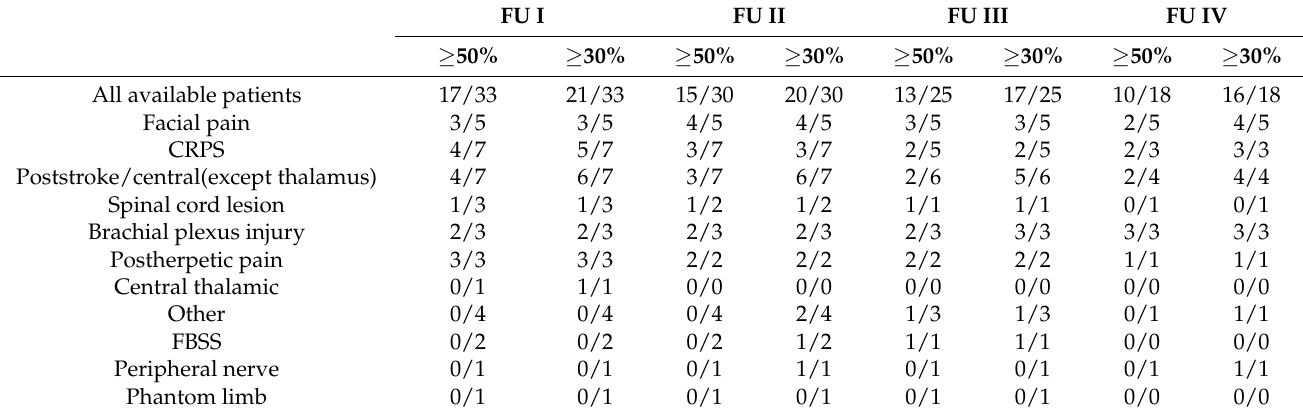
Table 3. Number of responders to thalamic DBS during follow-up (VAS average pain scores).